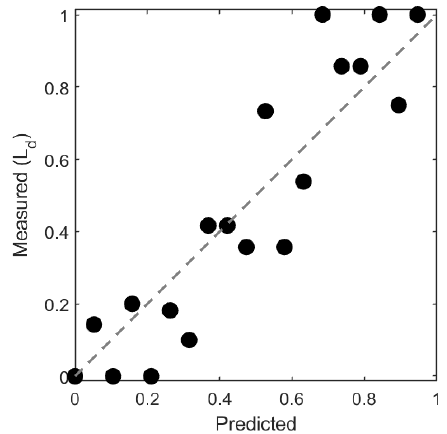
Figure 7. Scatter plot of measured versus predicted delta formation. Eq. (1) was used to calculate the predicted probability of delta for- mation, π delta , using rivers with necessary data available; n = 477 (2 / 3 of which was used for training and 1 / 3 used for validation). To compare predicted values from Eq. (1) to our collected data the binary observation of delta presence or absence was transformed into a continuous variable. To do this we created 20 equal intervals ( π delta = 0 . 05 bin widths) and averaged π delta values. L d is calcu- lated for each bin as the number of rivers with deltas divided by the total number of rivers. The dashed line represents a 1 : 1 relation-